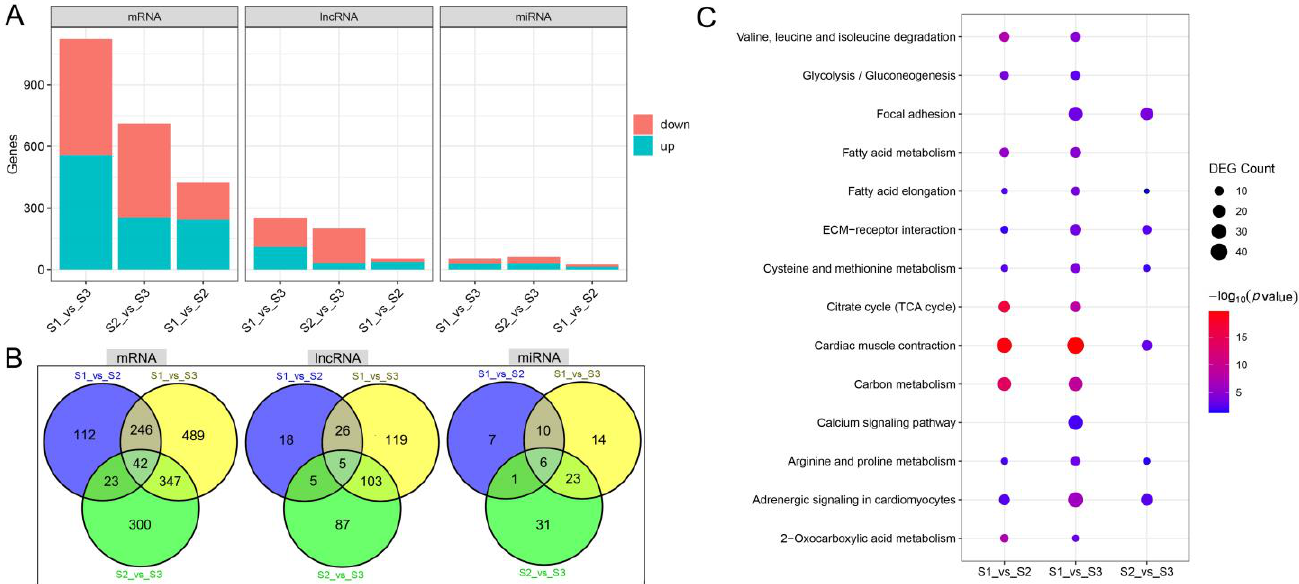
Figure 2. DEGs between S1, S2, and S3 segments. ( A ) The number of DEmRNAs, DElncRNAs, and DEmiRNAs of S1_vs_S2, S1_vs_S3, and S2_vs_S3. ( B ) Differences in the composition of DEmRNAs, DElncRNAs, and DEmiRNAs in S1_vs_S2, S1_vs_S3, and S2_vs_S3. ( C ) Differences in KEGG enrichment results of DEmRNAs of S1_vs_S2, S1_vs_S3, and S2_vs_S3.